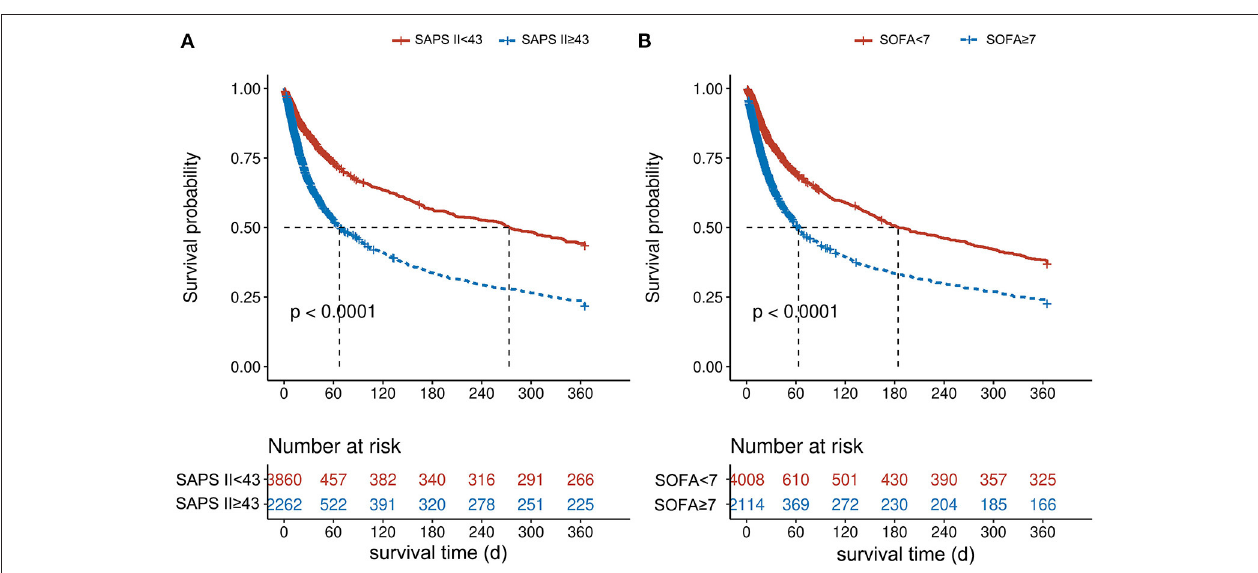
FIGURE 3 | Kaplan–Meier curves of 1-year mortality by scoring system groups. (A) For the SAPS II score, while (B) is for the SOFA score.